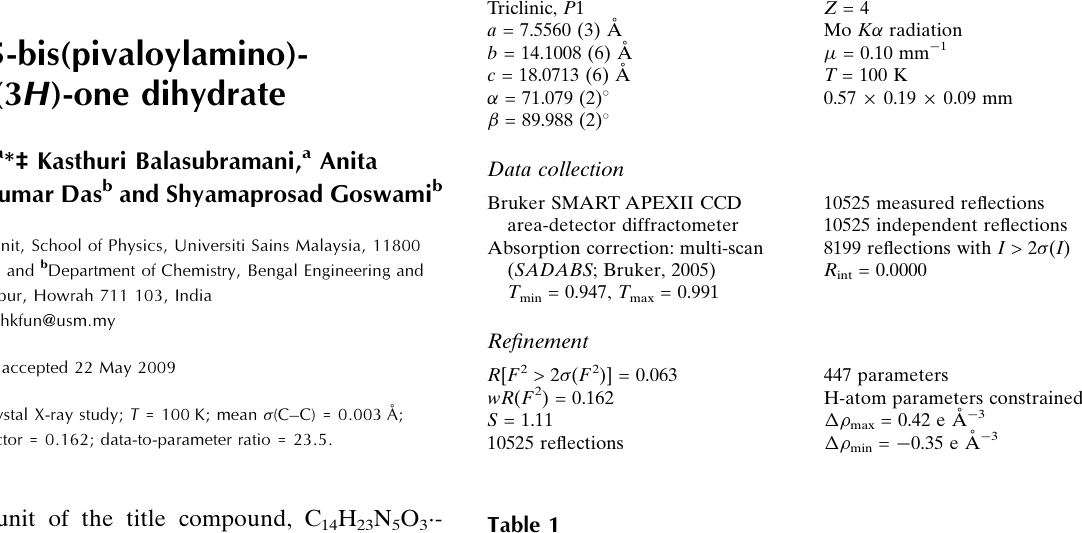
Hydrogen-bond geometry (A˚ , (cid:3)